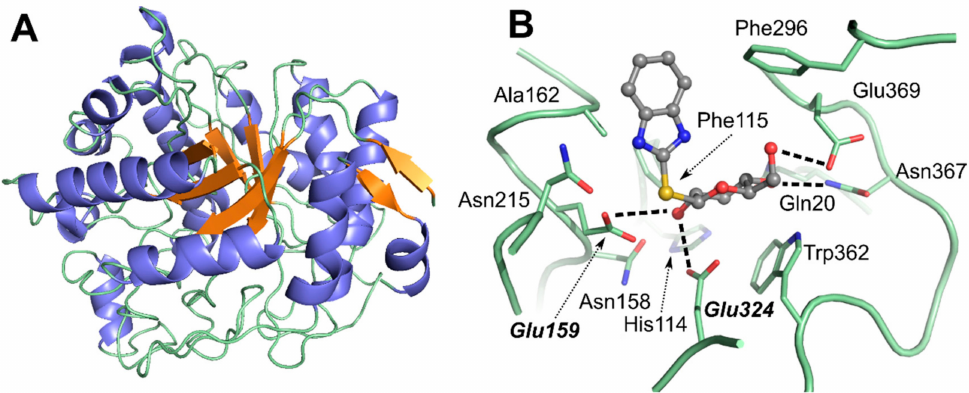
Figure 4. ( A ) Overall representation of Dt Gly model. Helices and sheets are respectively coloured in blue and orange. ( B ) Model of docked Glc S Biz in Dt Gly active site. Residues surrounding the ligand binding pocket are depicted as sticks. For clarity purposes, hydrogens are not represented. Catalytic residues Glu159 (acid / base) and Glu324 (nucleophile) are highlighted in bold. H-bonds are indicated as dashed